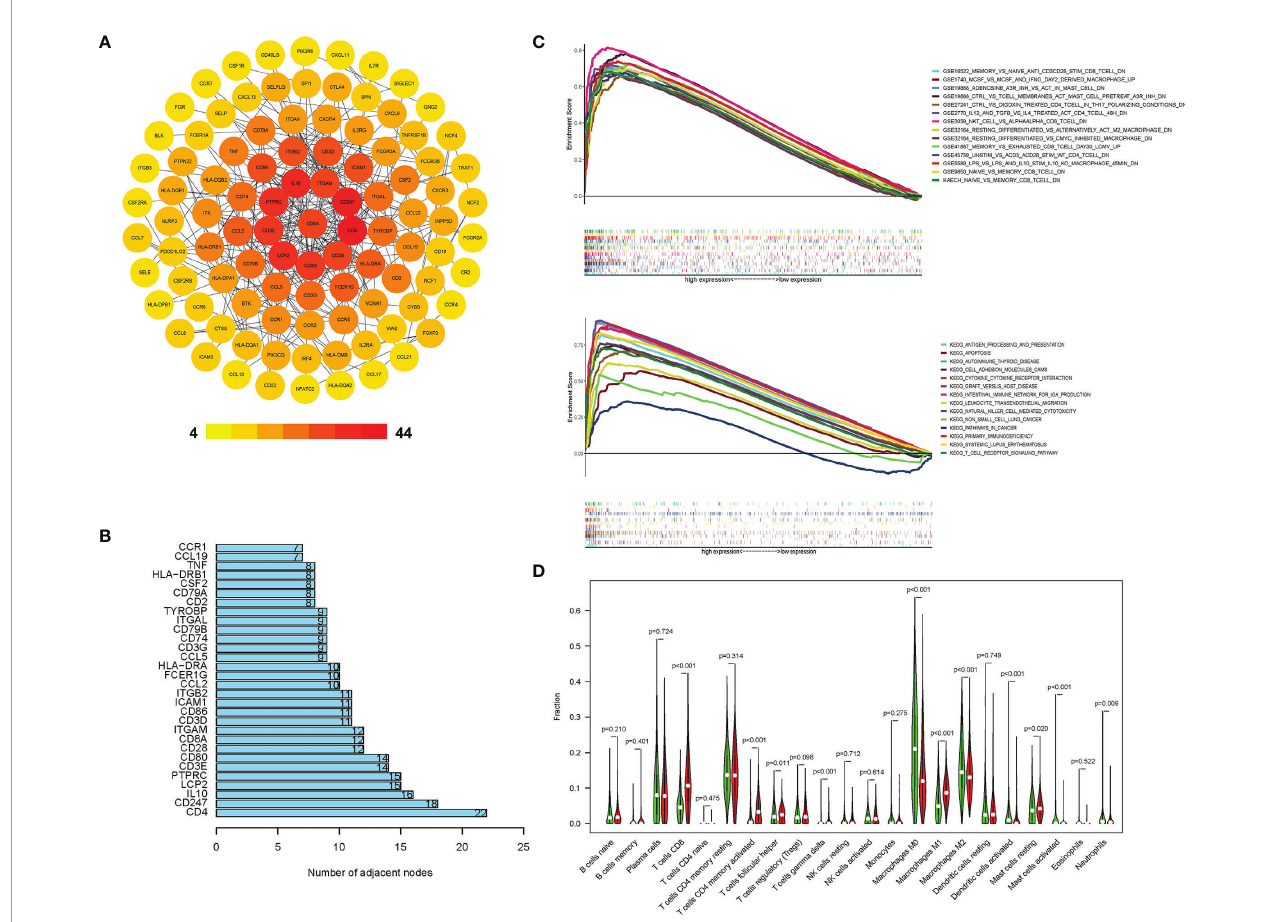
FIGURE 2 | CD8A correlated with other immune expression pro fi les in TCGA cohort. (A) PPI network of DEGs with integrated scores > 0.20, in which top 30 central genes were obtained (B) . The difference in KEGG, immunologic signature (C) , and immune cells ’ proportion (D) between the CD8-high and CD8-low